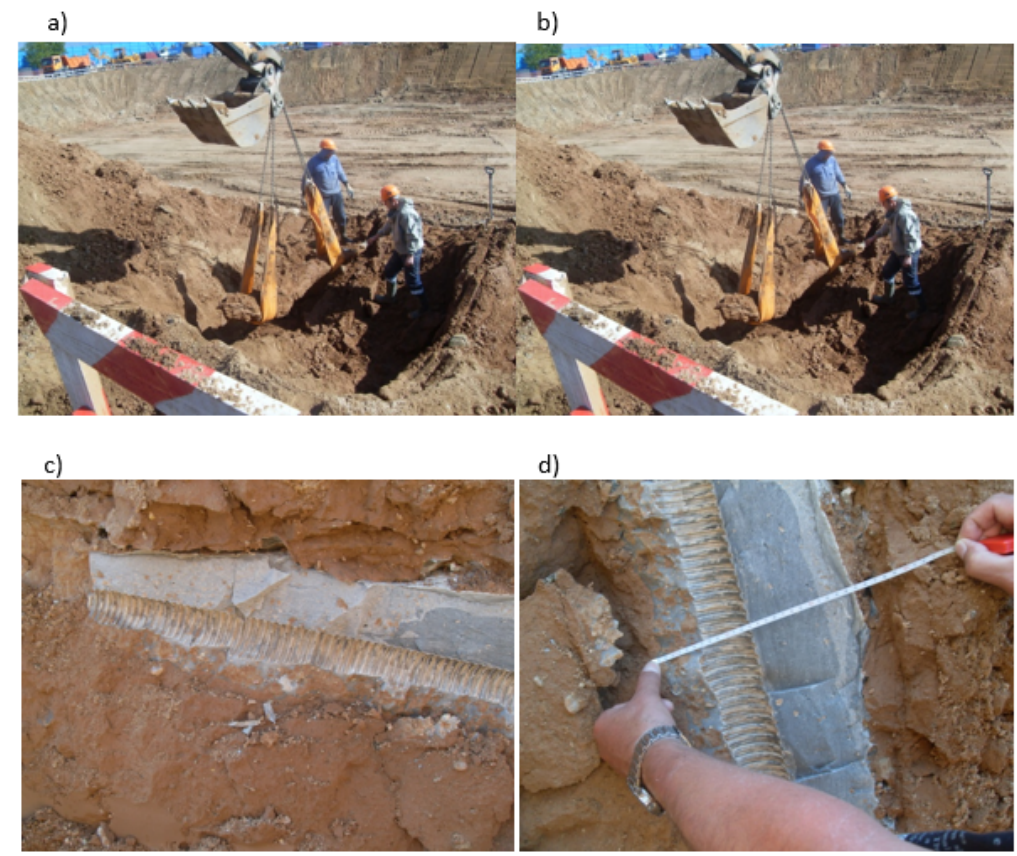
Figure 3. Removing from the ground (a) The form of excavated three anchor piles (b). Fragment of anchor piles body remaining in the ground (c), Measurement of the diameter on the contact with the stem (d).